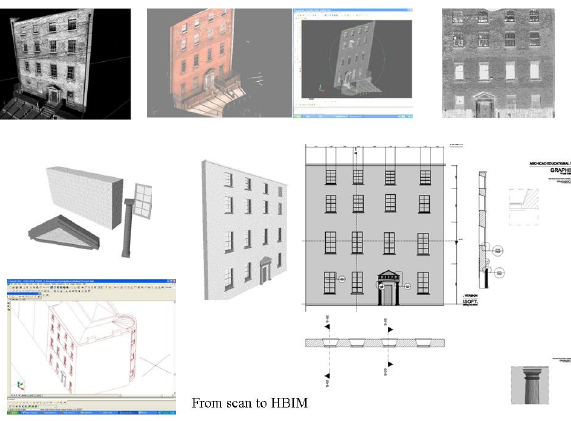
Figure 7 Mapping Objects onto Survey Data –